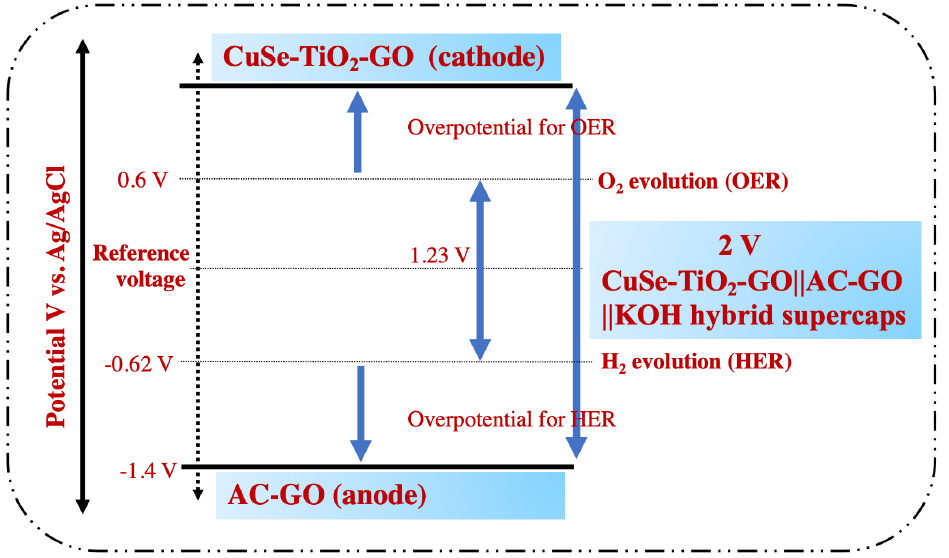
Figure 1. Schematic showing the expansion of the voltage region of the CuSe-TiO 2 -GO||AC- GO||KOH hybrid supercapacitor in an aqueous KOH electrolyte.